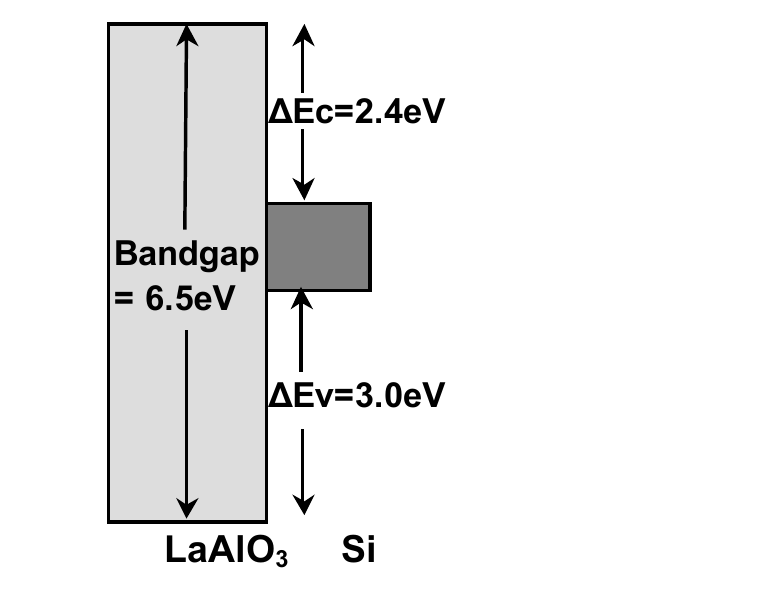
Figure 7. Energy-band profile of the LaAlO